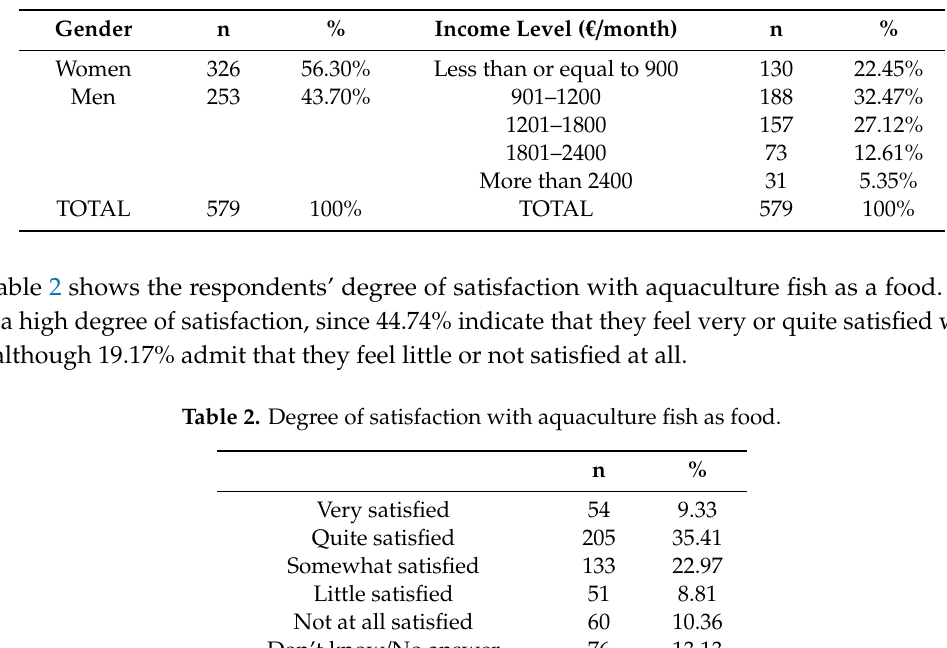
Table 1. Sample distribution.